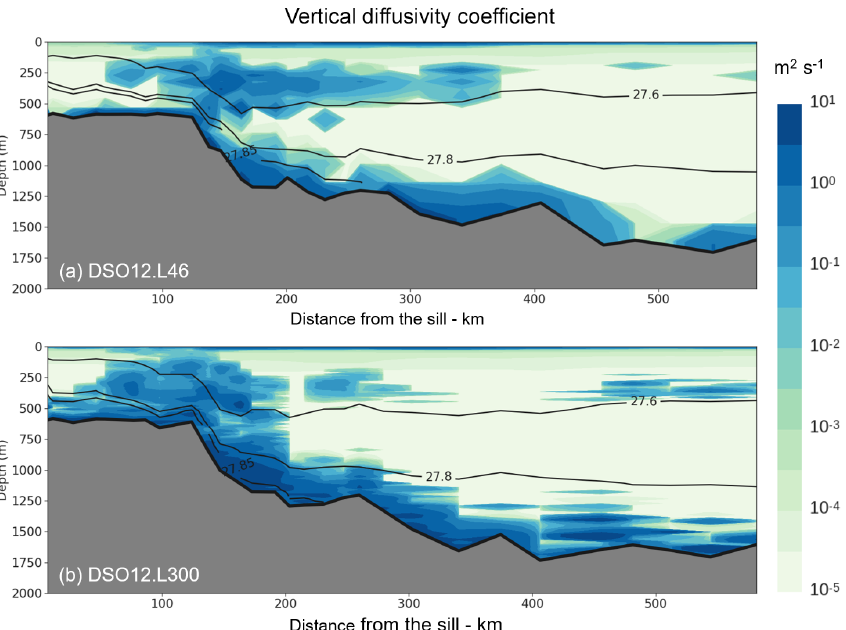
Figure 9. Vertical diffusivity coefficient ( K z , summer mean in the fifth year of simulation) along the path of the vein calculated for (a) sim- ulation DSO12.L46 and (b) simulation DSO12.L300. Potential density values ( σ 0 ) are shown by the contour